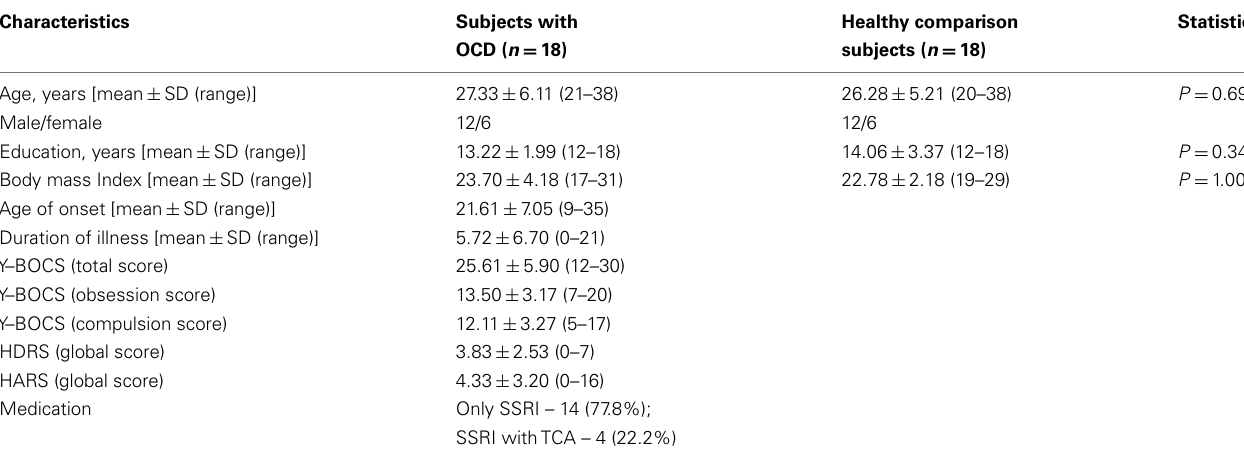
Table 1 | Sociodemographic and clinical characteristics of patients with obsessive–compulsive disorder and healthy comparison subjects.